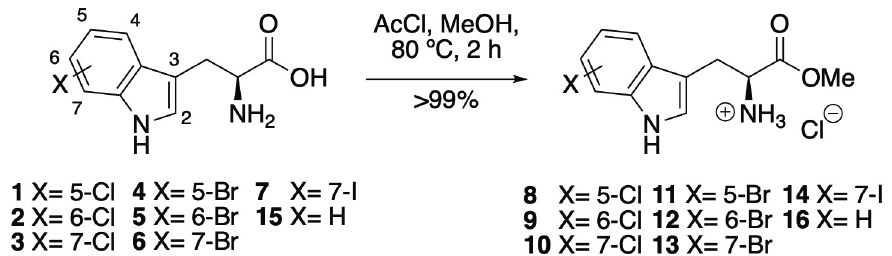
Fig 1. Conversion of halogenated tryptophan analogues 1–7 to their corresponding methyl esters 8–14, as well as natural tryptophan (15) to 16. The general structure for tryptophan analogues 1 – 7 is labelled with standard indole ring system numbering for clarity.